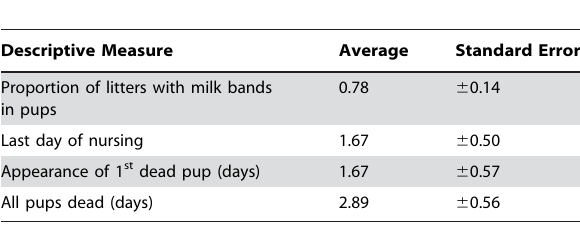
Table 1. Descriptive measures of litters that would eventually be neglected in Generation